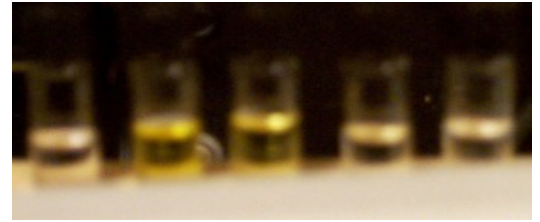
FIGURE 3. Room light photo of Eu-OP samples. See text. Left to right in: methanol/water, clear; methanol + 1 drop of paraoxon, yellow;